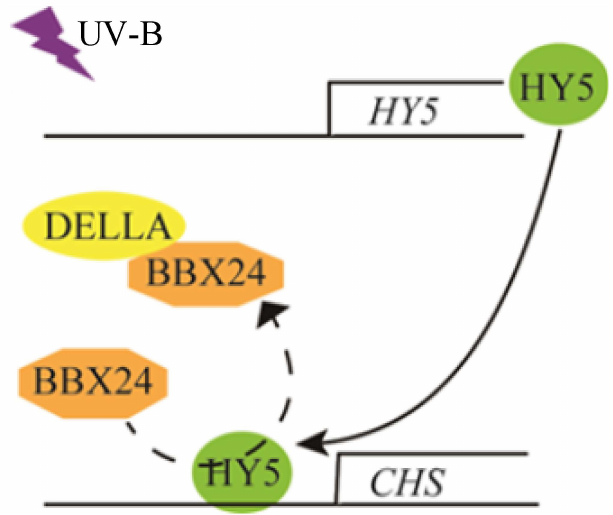
Figure 8. A possible working model of DELLA involved in UV-B-induced